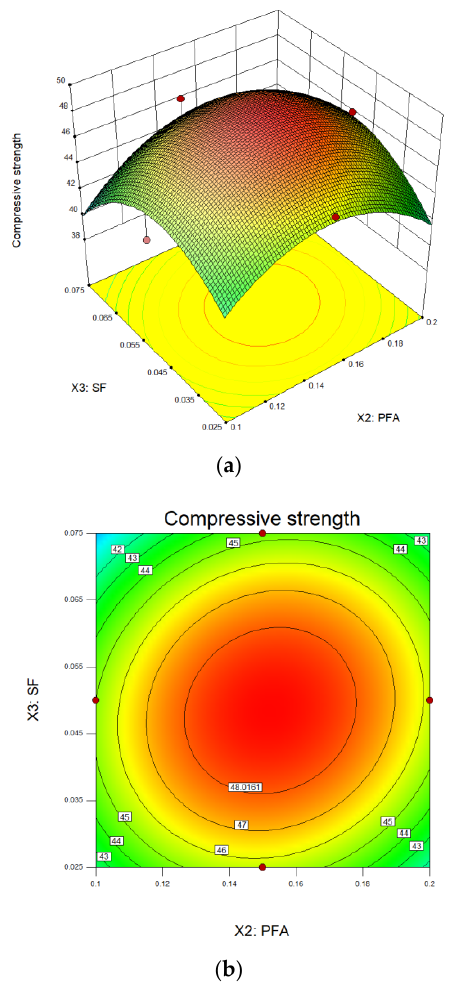
Figure 8. Response surface and contour in SFA-SF. ( a ) Response surface. ( b ) Contour.